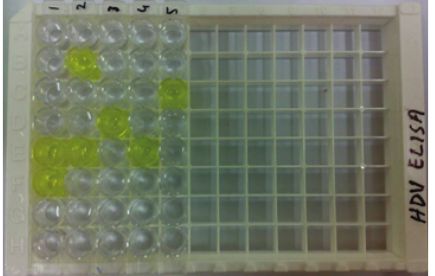
Figure 3: Anti-HDV Abs ELISA Plate: W 1A and 1B: blank, W 1C and 1D: negative controls, W 1E and 1F: positive controls, and W 2B, 2E, 3D, 4E, and 5C: anti-HDV Ab positive samples (W: Microtiter Well).